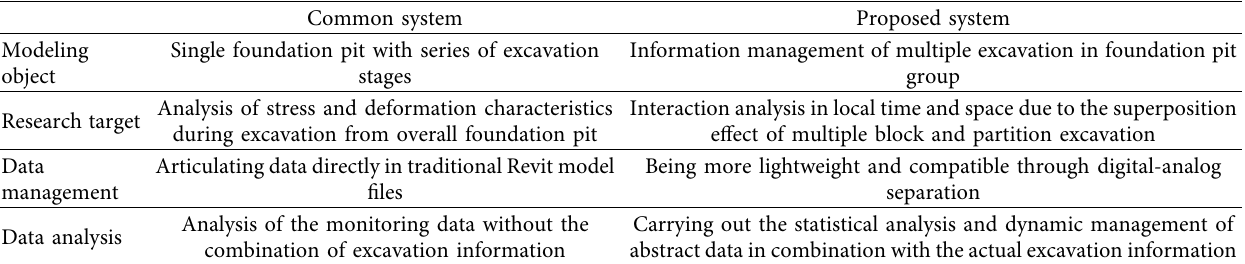
Table 1: The difference between proposed system and common risk monitoring